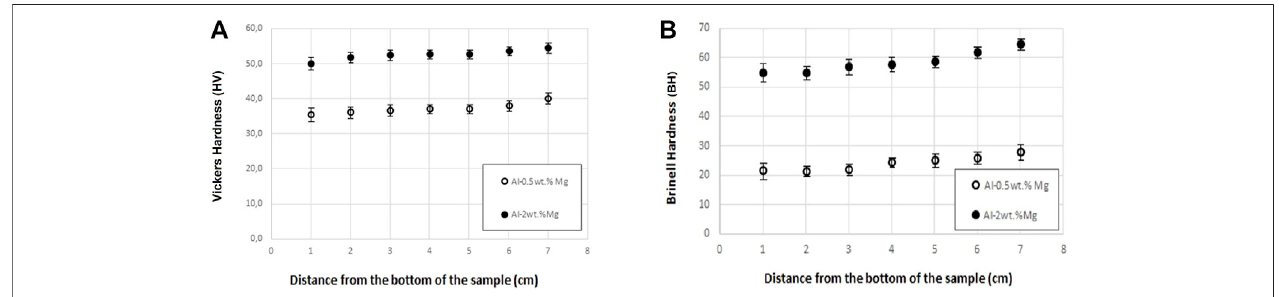
FIGURE 6 | Potentiodynamic curves of Al-Mg alloys. (A) Al-0.5wt.% Mg (Longitudinal section). (B) Al-0.5wt.% Mg (Transversal section). (C) Al-2wt.% Mg (Longitudinal section). (D) Al-2wt.% Mg (Transversal section).